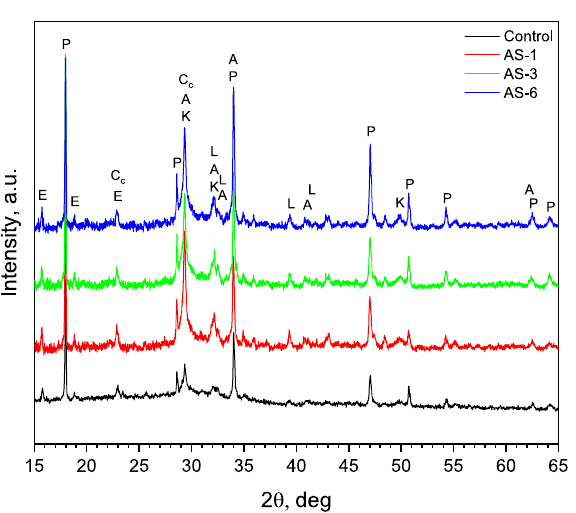
Figure 12. X-ray diffraction pattern of sonicated CNT-LWAC specimens. A—alite Ca 54 MgAl 2 Si 16 O 90 (13–272); E—ettringite